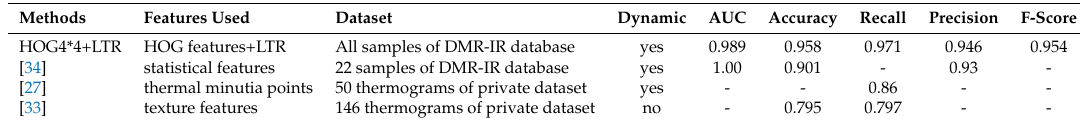
Table 8. Comparison with related